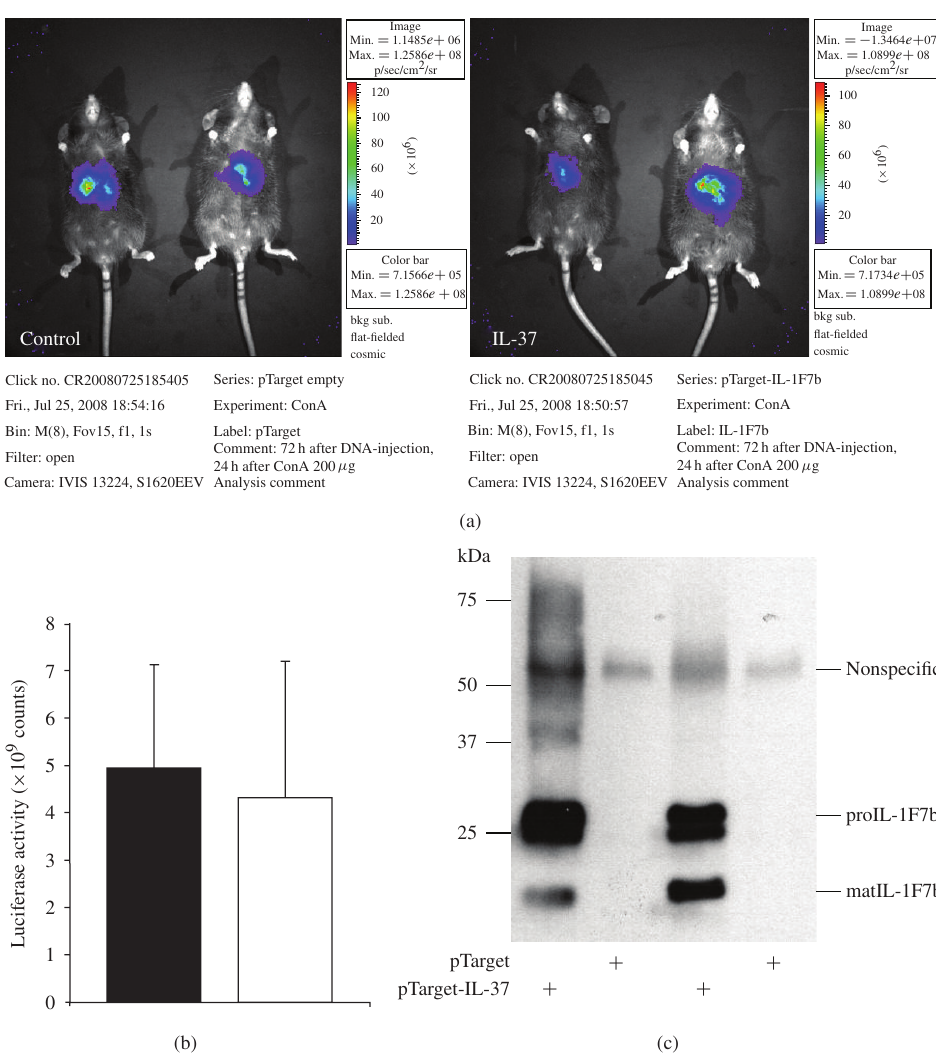
FIGURE 1: In vivo luciferase activity in the liver of C57/BL/6 mice after hydrodynamic tail vein injection of plasmid-DNA. C57/Bl6 mice were rapidly injected with pTarget-IL-37 (20 μ g) and pLuc plasmid-DNA (1 μ g) in 2 mL of Ringer’s solution. After 48 hrs concanavalin A 200 μ g was applied into the tail vein. 24 hrs after ConA injection, luciferase expression was measured in vivo using the IVIS imaging system (a). Luciferase activity in IL-37-expressing mice (open bar) and control mice (closed bars) (b). IL-37 protein detected in liver lysate of mice injected with IL-37-pTarget plasmid mice and control mice (empty pTarget) by Western blotting